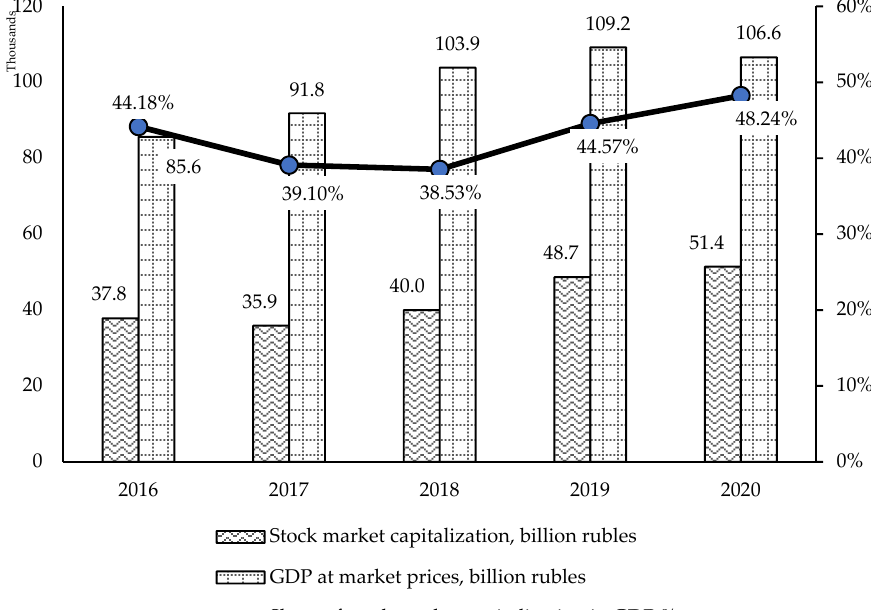
Figure 1. Dynamics of the share of capitalization of the stock market in GDP and its components in